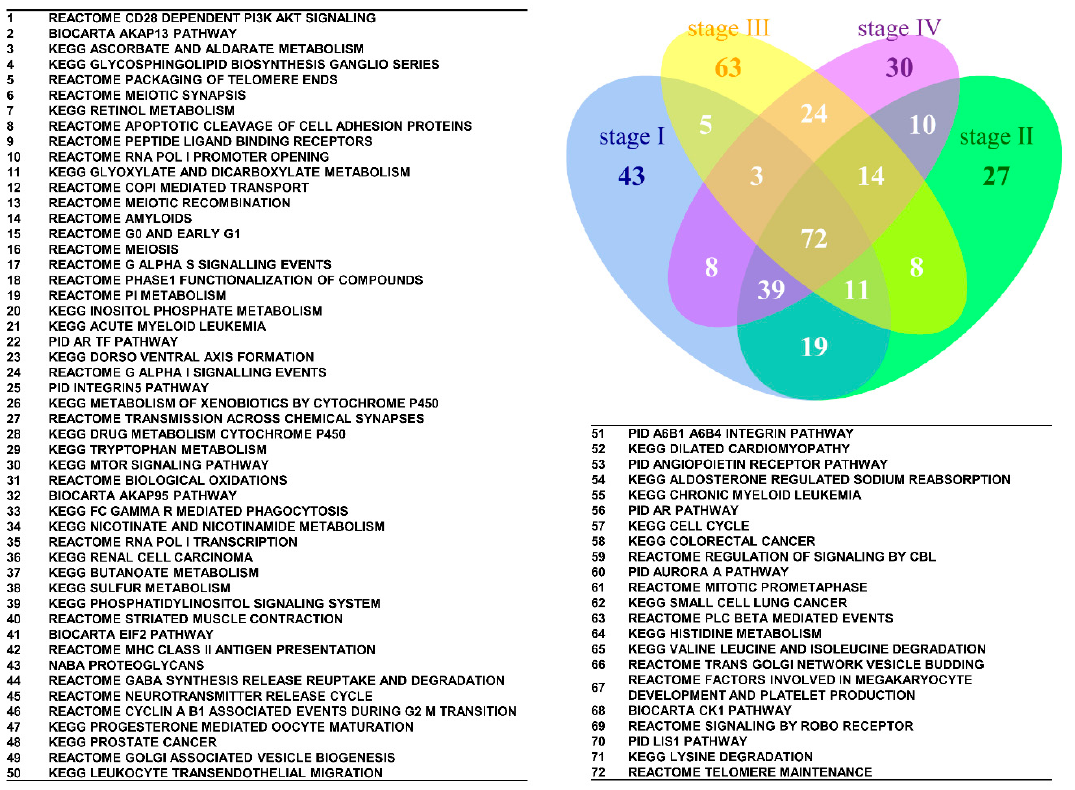
Figure 5. Venn diagram of the 200 most significantly deregulated canonical pathways for the stage I–IV groups. The results of the set analysis of the stage I–IV groups showing the 200 most significantly deregulated canonical pathways ranked by their p values are displayed on the Venn diagram to show the gene set numbers of all possible logical relations among the stage I–IV groups. The 72 most commonly deregulated canonical pathways among the four groups are listed.